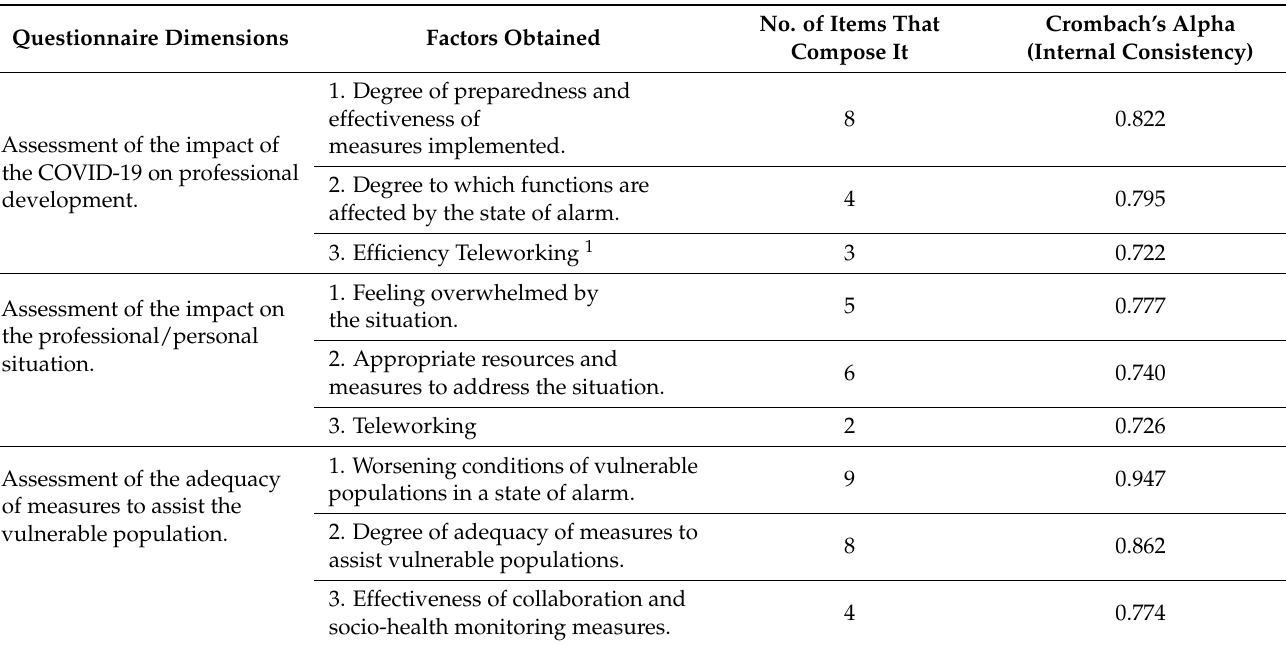
Table 1. Factorial analysis.